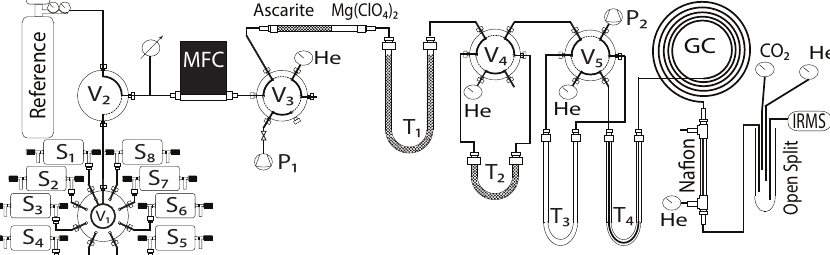
Figure 1. A diagram of the continuous-flow isotope-ratio mass spectrometry system for measuring 13 C and 18 O of CO. S 1 to S 8 represent the sample flasks; the connections to the flask can be changed to accommodate other types of cylinders or cans. The multi-sample inlet system can be evacuated by a pump (P 1 ). V 1 , V 2 , V 3 , V 4 , and V 5 are Valco valves. The sample is admitted to the analytical system via a mass